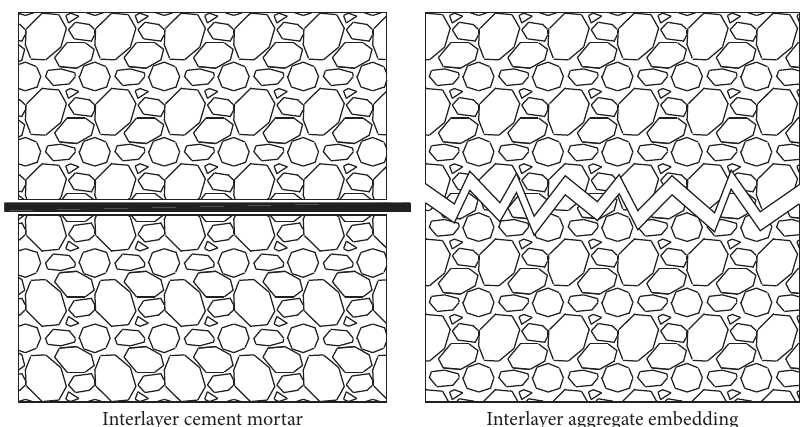
Figure 1: Interlayer adhesion schematic of traditional paving and double-layer continuous paving.